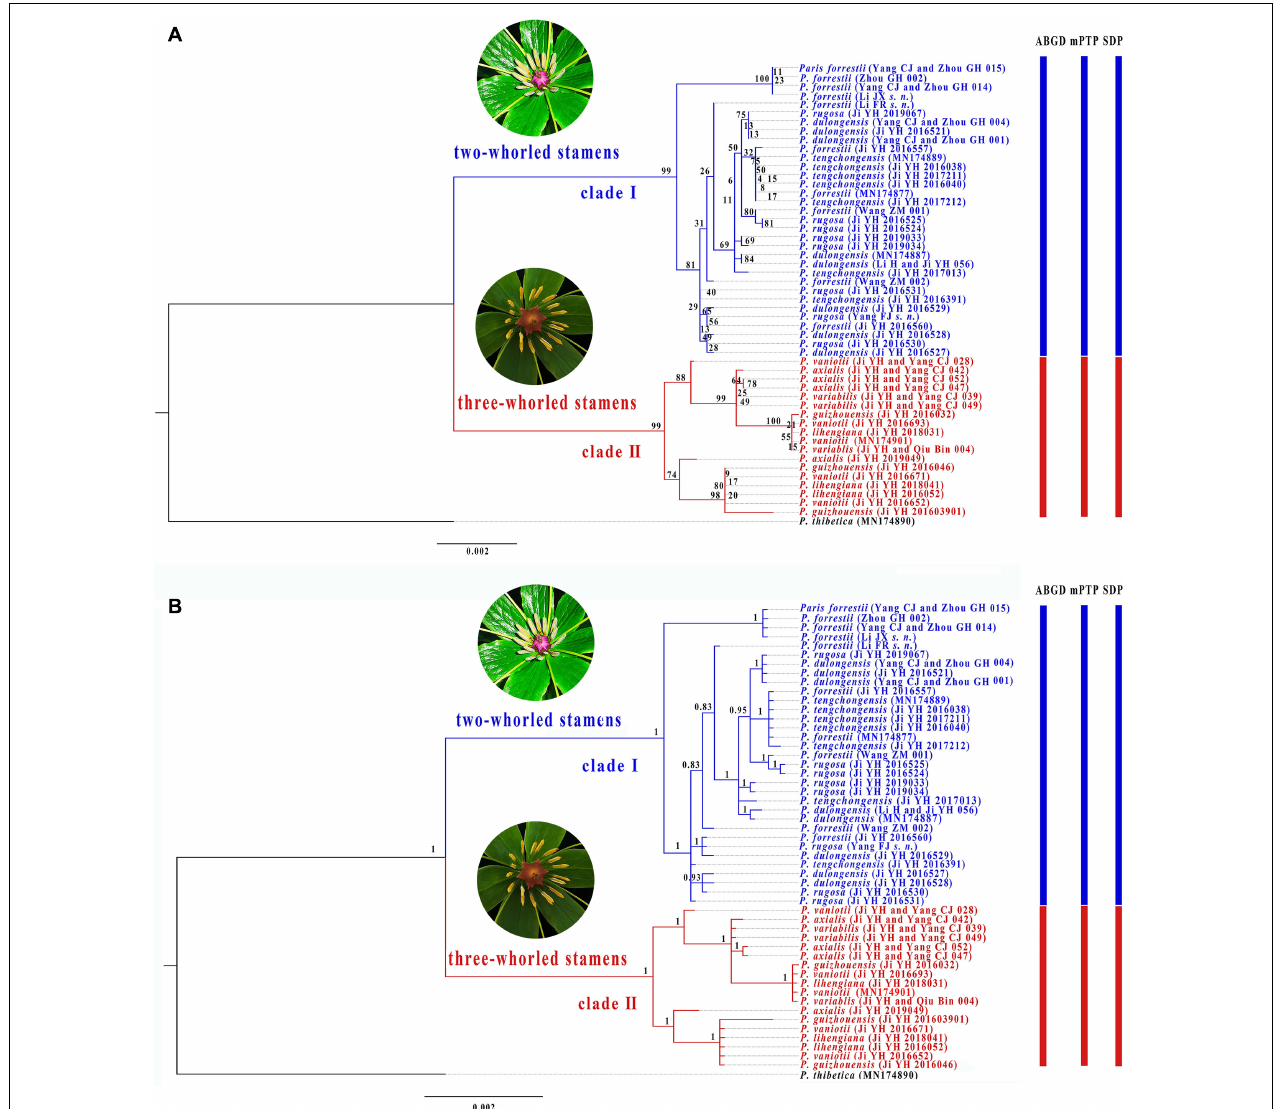
FIGURE 4 | Phylogenetic tree of Paris section Axiparis based on Maximum likelihood (ML, A ) and Bayesian inference (BI, B ) analyses of nuclear ribosomal DNA (nrDNA). Numbers above branches indicate ML bootstrap (BS) percentages and Bayesian posterior probabilities (PP). Species delimitation schemes proposed